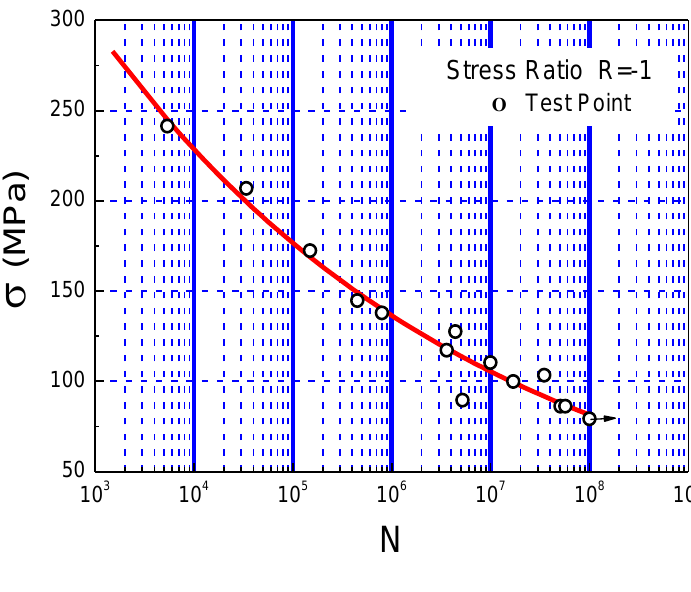
Figure 8. S-N curve of 6061-T6 aluminium